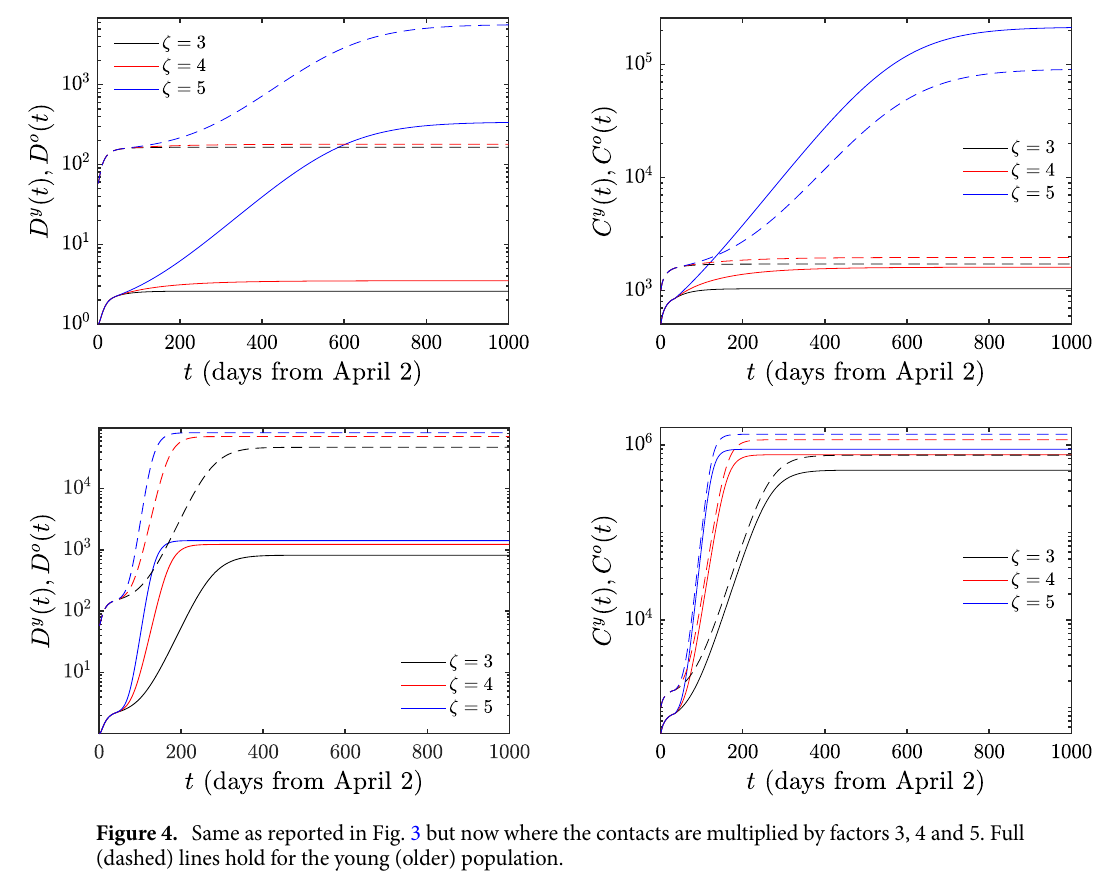
Figure 4. Same as reported in Fig. 3 but now where the contacts are multiplied by factors 3, 4 and 5. Full (dashed) lines hold for the young (older) population.